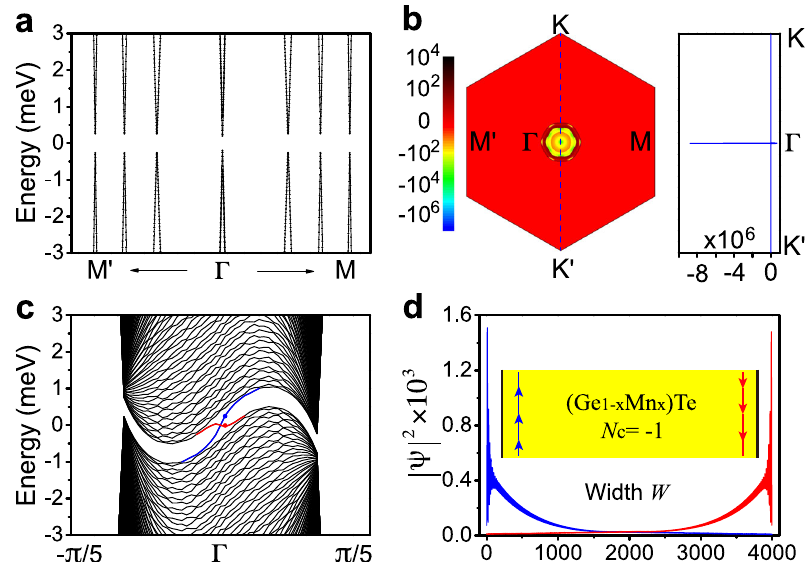
Fig. 3 The topological superconductivity of 0.1-hole-doped Ge 1- x Mn x Te monolayer. a The dispersion relation of quasi-particles calculated by the fi rst-principles BdG Hamiltonian. b The distribution of total Berry curvatures for the states below the superconducting gap in the fi rst BZ (left panel) and along the line of K- Γ -K ’ (right panel). c The energy spectra of quasi-particles in a nanoribbon with the width (W) of 4000 primitive cells. The chiral Majorana edge modes are highlighted by red and blue lines. d The spatial distributed probability density of the in- gap states indicted by red and blue dot in ( c ). The inset is a schematic diagram of chiral Majorana edge modes with different propagation direction on opposite